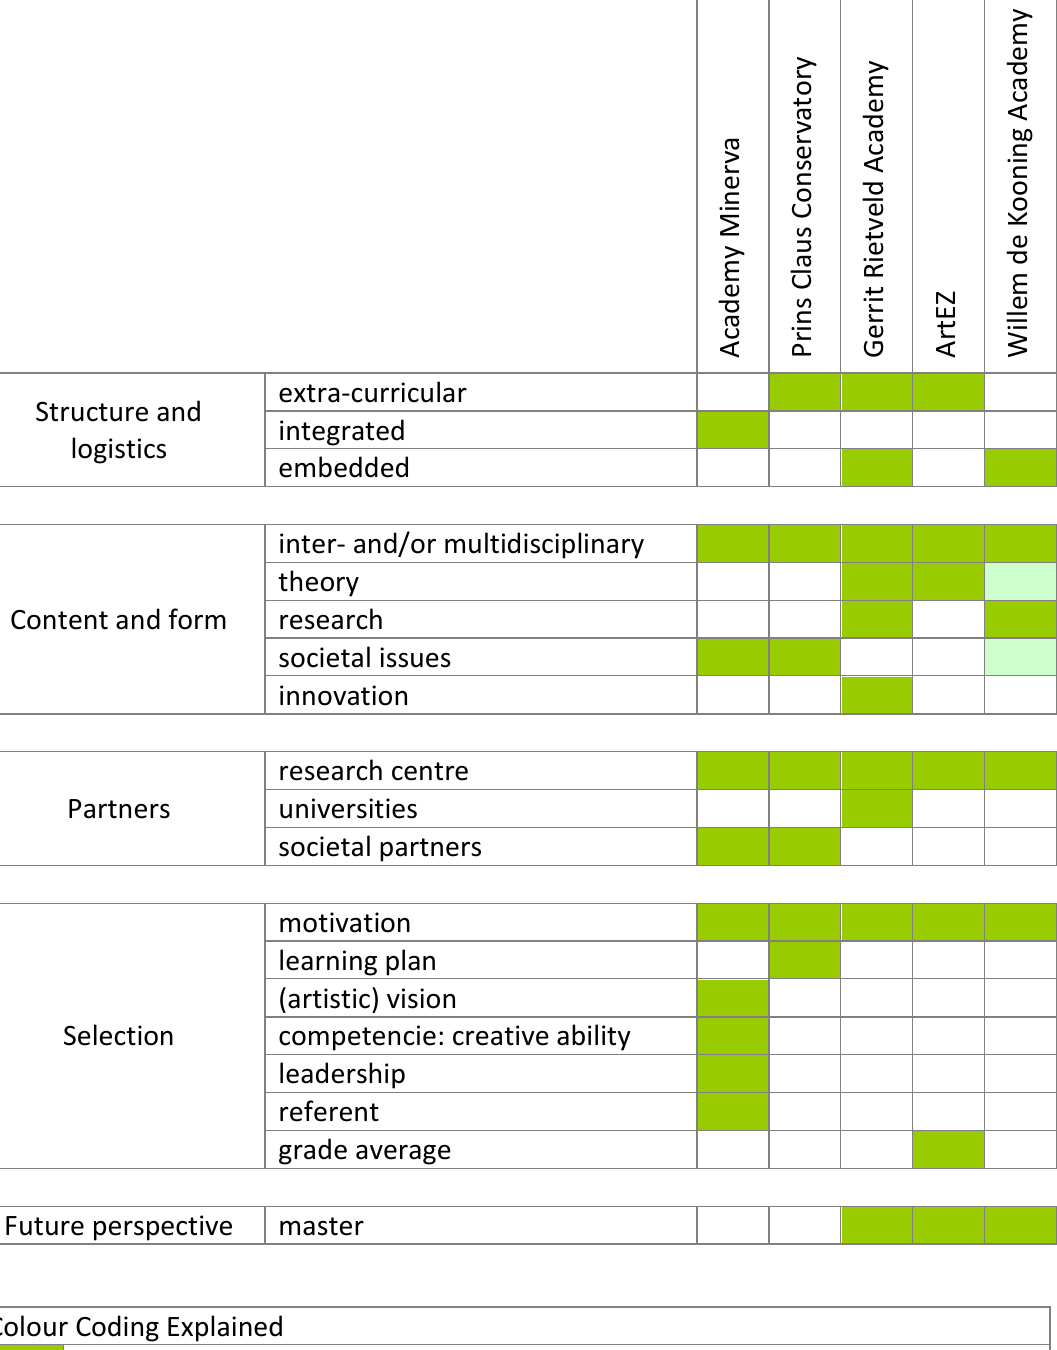
Table 2: Profile of Honours Programmes at Dutch Universities for the